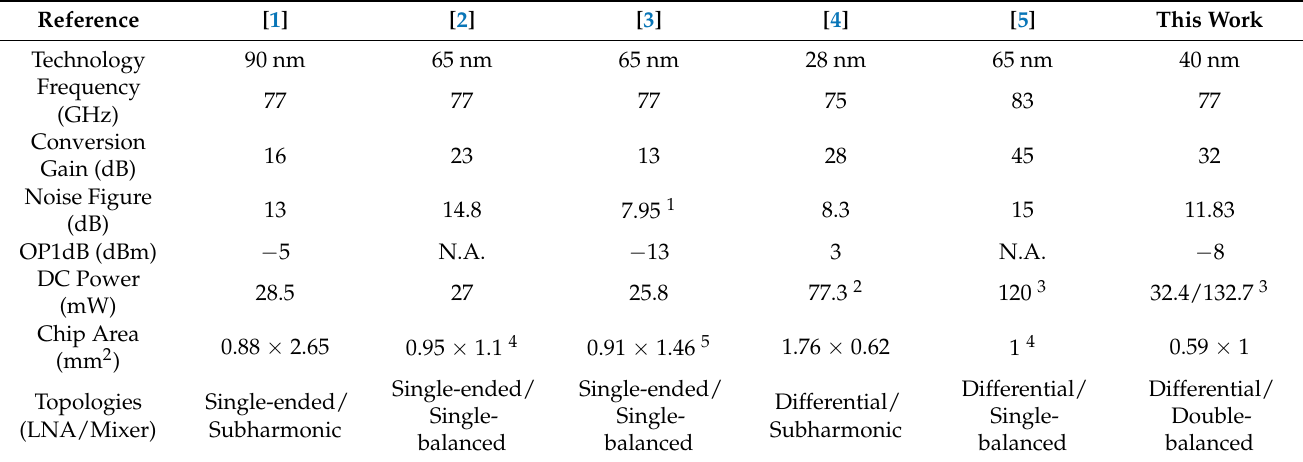
Table 1. Performance comparison with other receiver